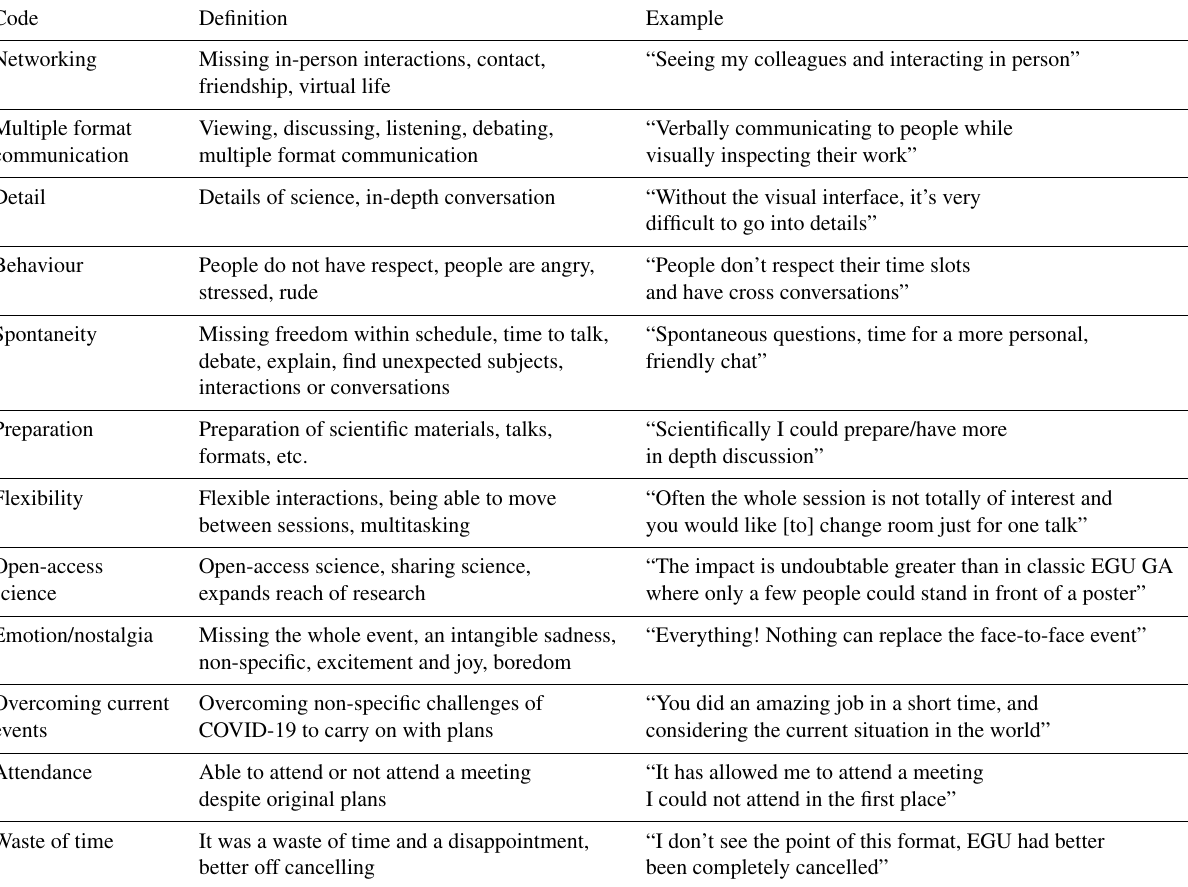
Table 1. The code book that was used by Hazel Gibson in the initial coding exercise, including a definition and an example for each code.